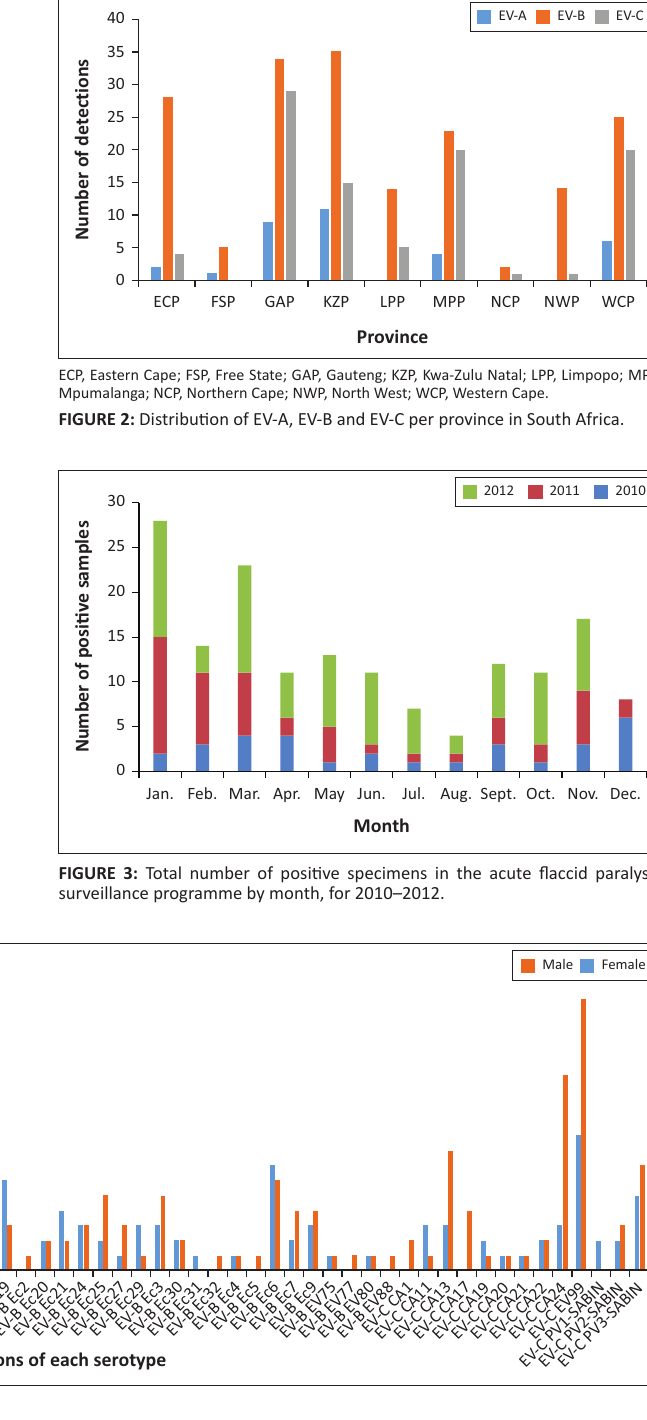
FIGURE 1: Infections of each serotype in males and females.